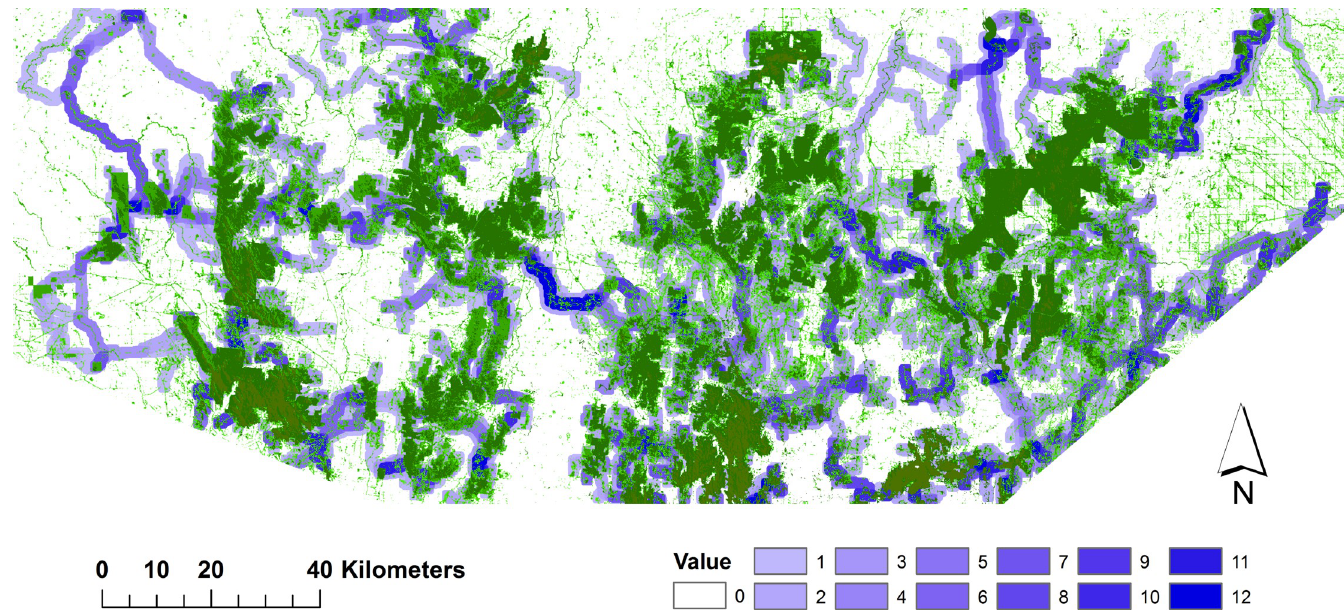
Fig 5. Composite regional connectivity map using resistance surfaces based on expert-assigned scores for land-cover classes. It is based on the combined results across all 12 study species. Favoured pathways are shown by darker blue shading, and existing wooded vegetation is in green.